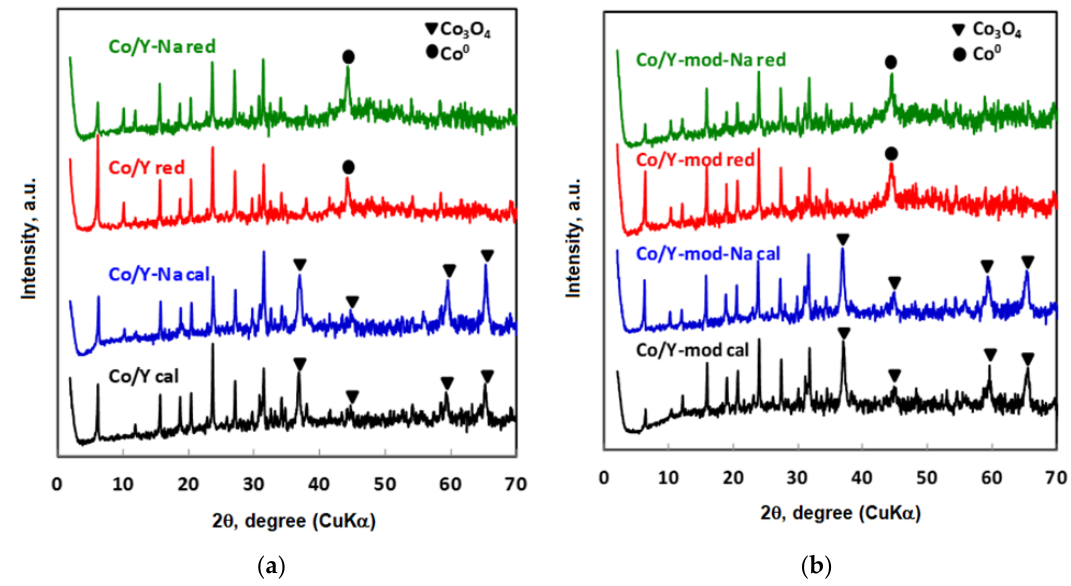
Figure 4. XRD of calcined and reduced Co catalysts (reduction conditions: 100 mL/min H 2 at 873 K for 3 h). ( a ) Catalysts prepared using the pattern Y zeolite as support. ( b ) Catalysts prepared using mesoporized Y zeolite (Y-mod) as support.